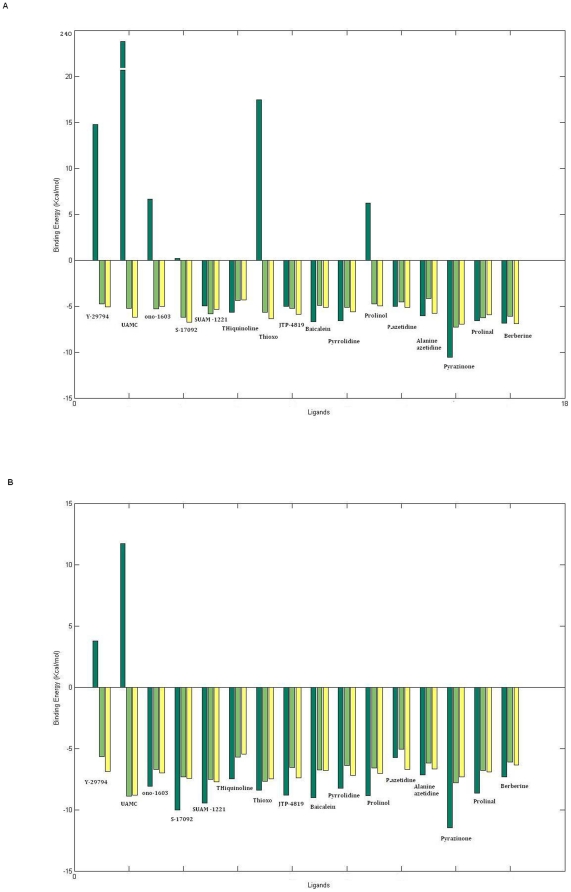
Rigid and flexible docking binding scores.
a) Rigid docking scores of human, porcine and A. thaliana POP. Some of the ligands showed hindrance in binding to human POP as revealed by their positive energy scores. Different ligands showed difference in binding affinities to three species of POP. b) Flexible docking scores of human, porcine and A. thaliana POP. After inducing flexibility in ligands still two of the ligands were incapable of binding to human POP.